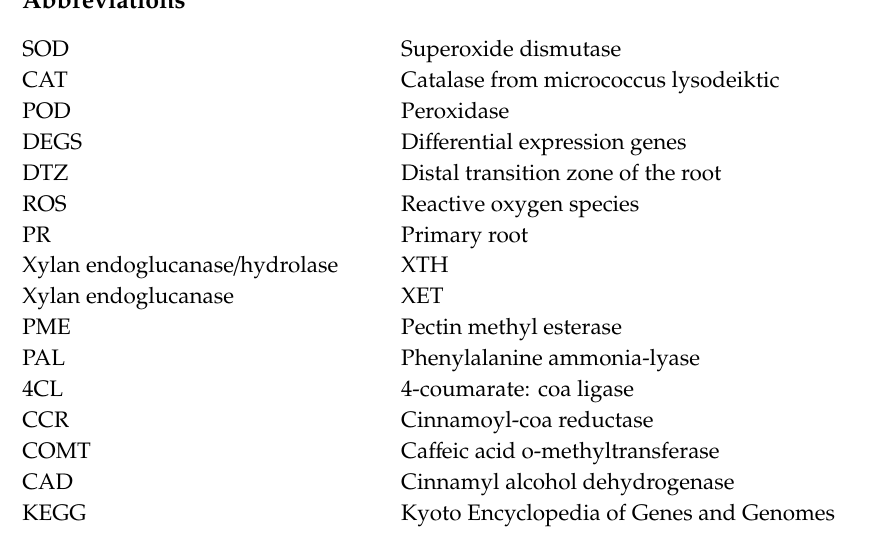
Figure S2. Volcanic map of di ff erentially expressed gene (DEGs); Figure S3. GO enrichment of three comparative combinations of aluminum stress in di ff erent periods; Figure S4. Trend clustering of DEGs; Figure S5. Heat map of DEGs expression in response to aluminum stress in various periods; Table S1. Quality evaluation of sequencing data; Table S2. Statistics on the alignment of lean reads and reference genomes; Table S3. Primer pairs used to verify gene fluorescence quantification; Table S4. High expression of transporters-encoding and protein kinases encoding genes; Table S5. New DEGs and unnamed